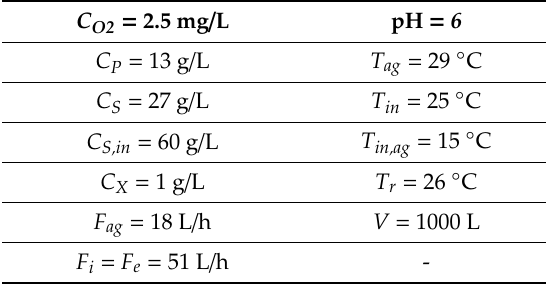
Table 2. Nominal operating conditions of the process.